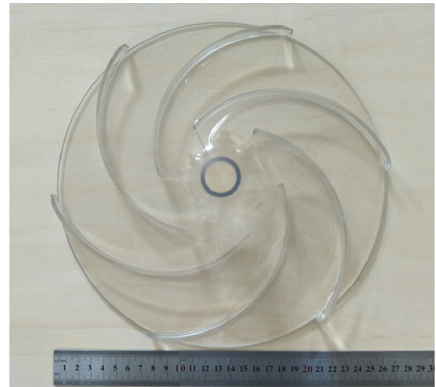
Figure 9: Test impeller.